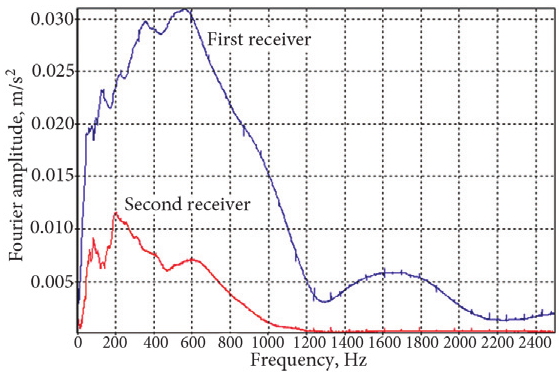
fig. 9. Auto-power spectrum for the first and second receiver at 100 cm receiver spacing, measured at the Cikampek-